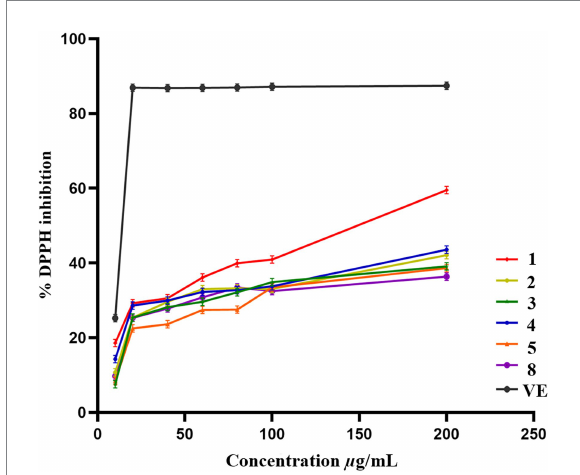
FIGURE 7 Antioxidant activities of compounds 1-5 and